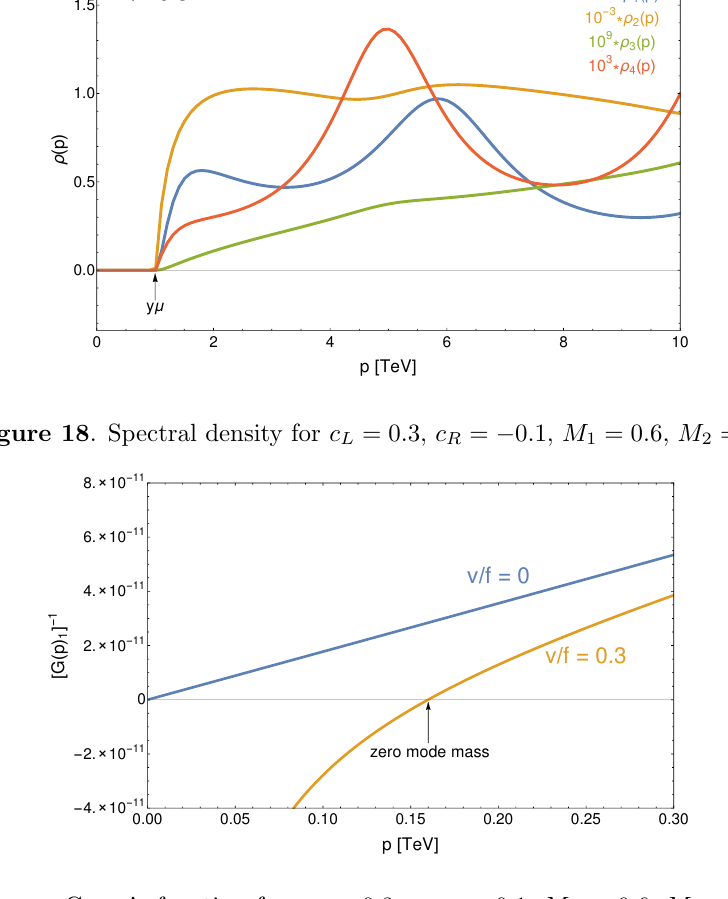
Figure 19 . Inverse Green’s function for c L = 0 : 3 ; c R = (cid:0) 0 : 1 ; M 1 = 0 : 6 ; M 2 = 0. The inverse Green’s function gets a non-trivial zero for v=f = 0 :